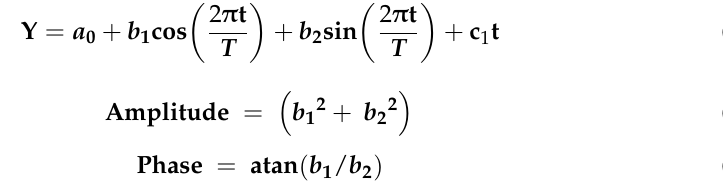
ogy based on the average NDVI value across each vegetation type at the time of each Landsat image.